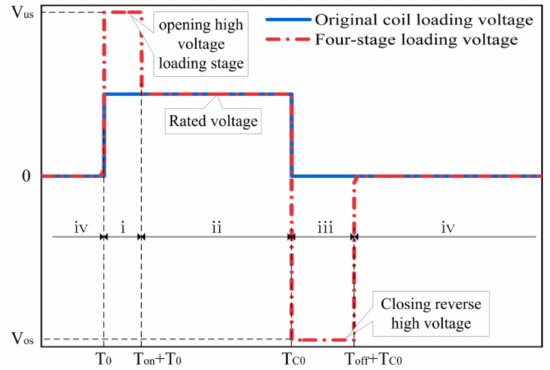
Figure 6. Positive and negative pulse voltage control strategy.